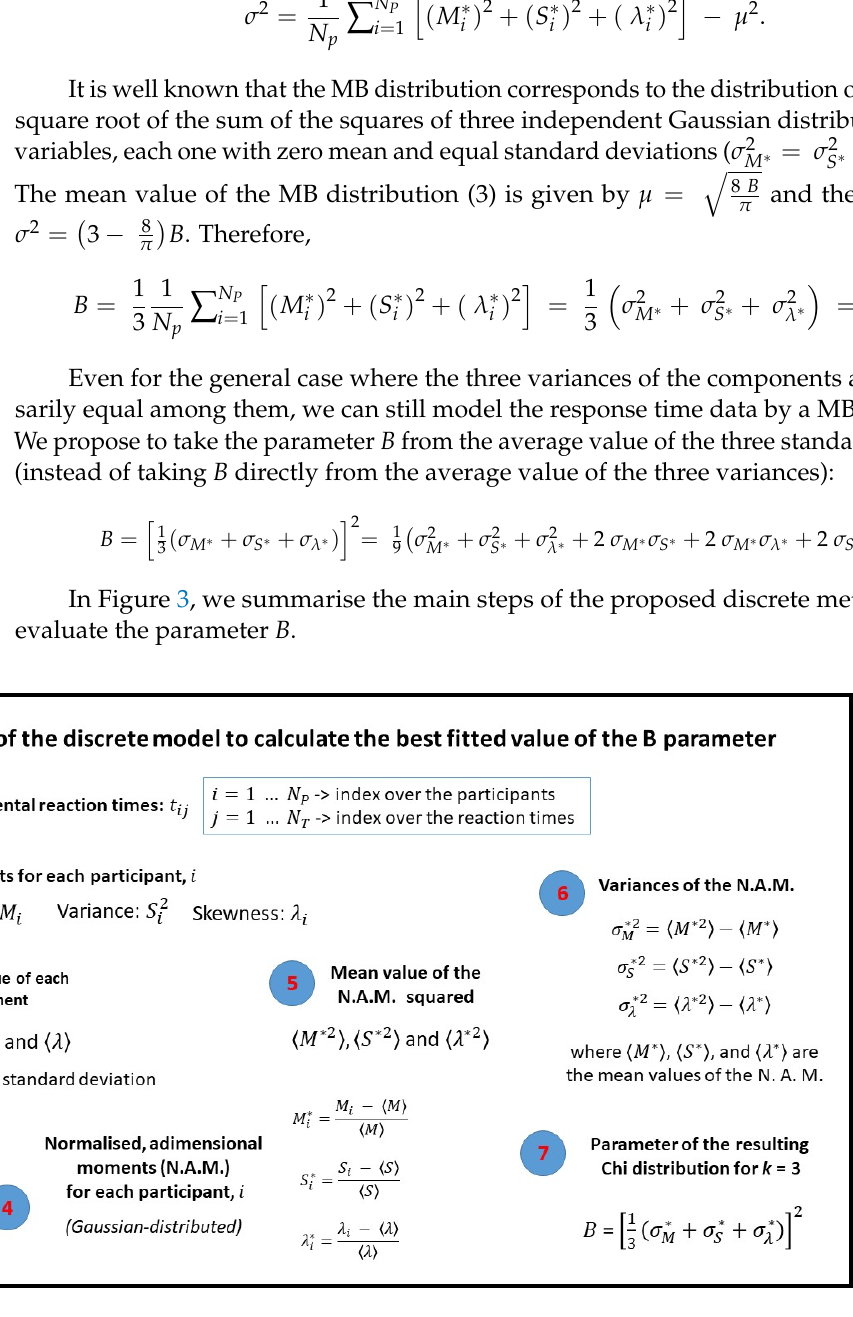
Figure 3. Chart summarising the main steps of the discrete methodology for the calculation of the parameter 𝐵